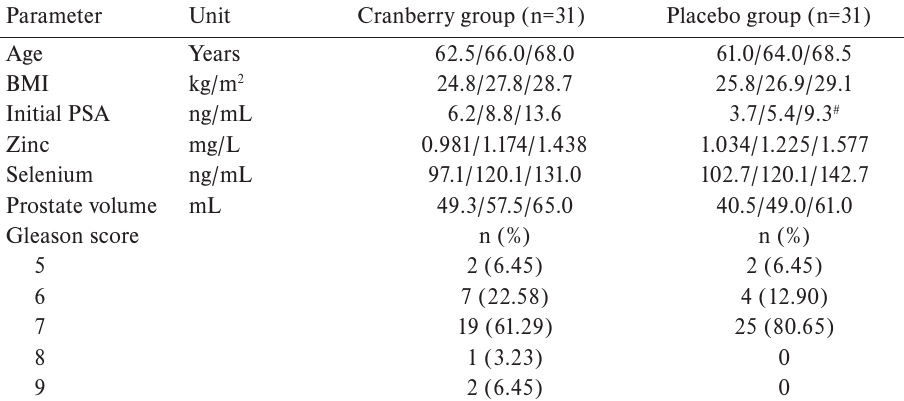
Table 1. Patient baseline demographics and clinical characteristics.